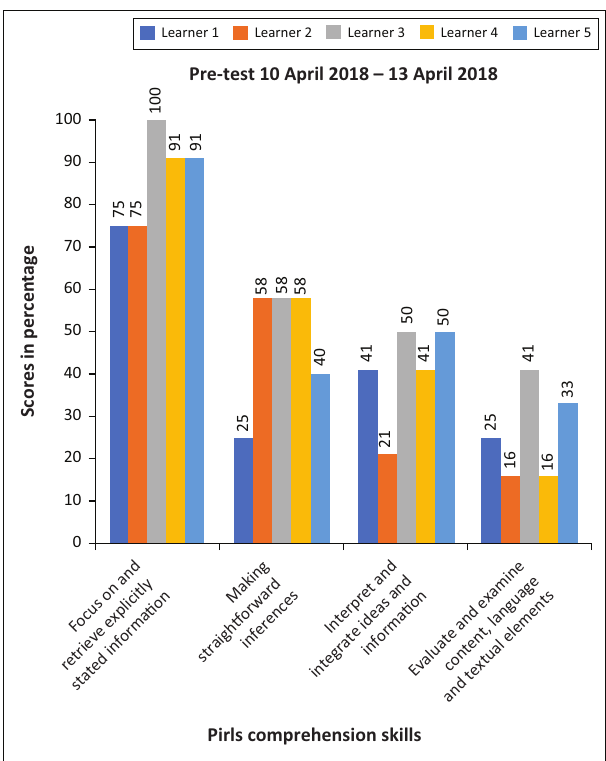
FIGURE 1: The pre-test results of the five Grade 3 learners.